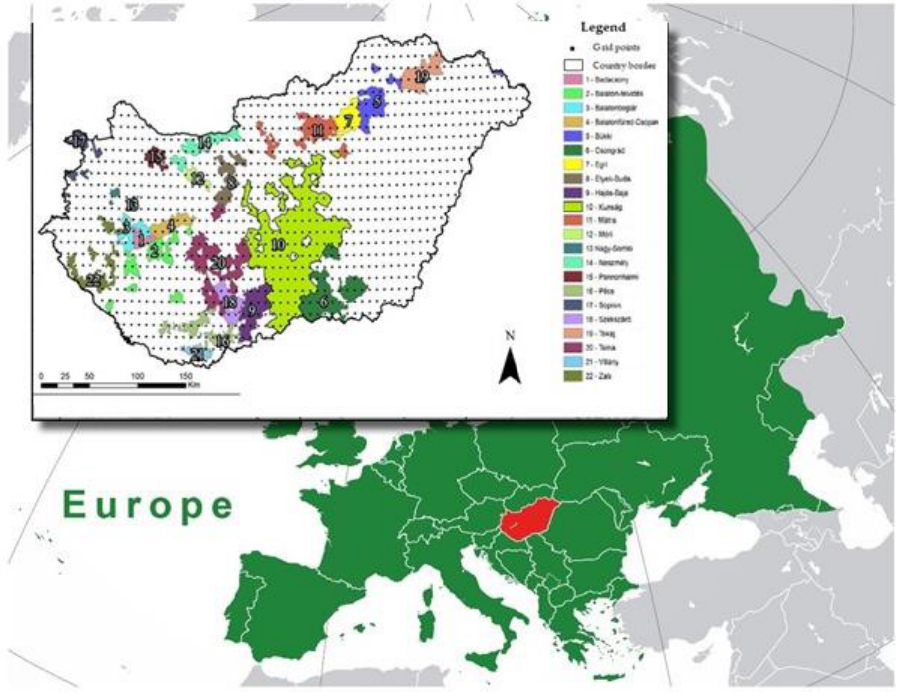
Figure 1 . Location of the 22 wine regions in Hungary. Figure 1. Location of the 22 wine regions in